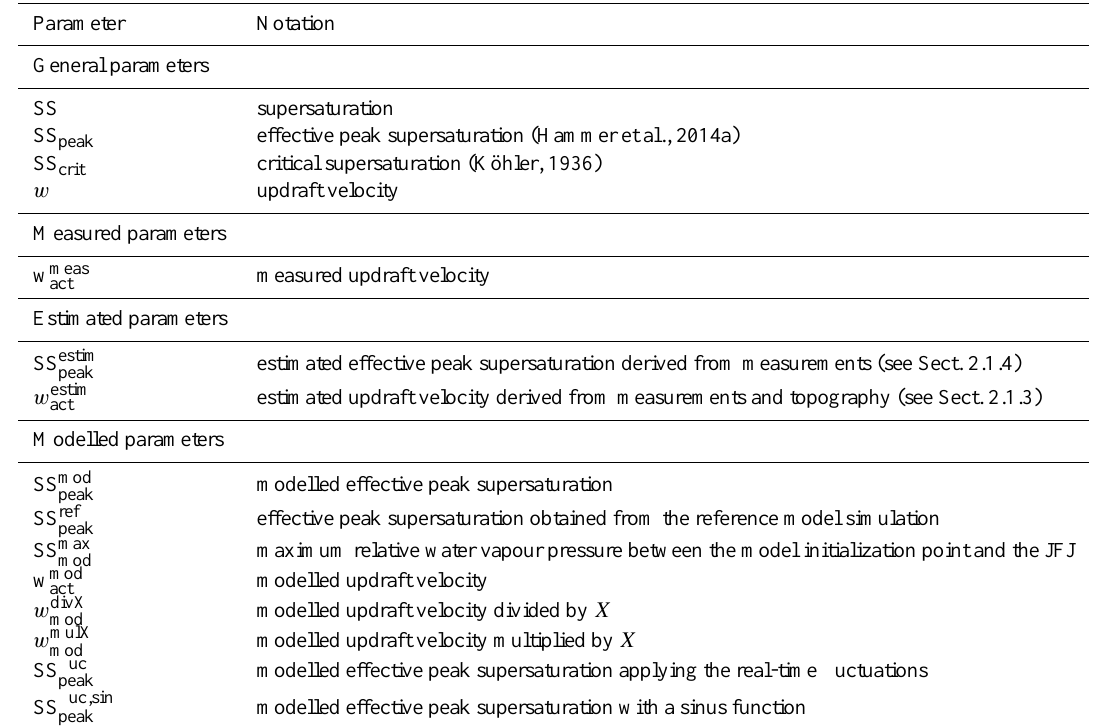
Table 1. List of important